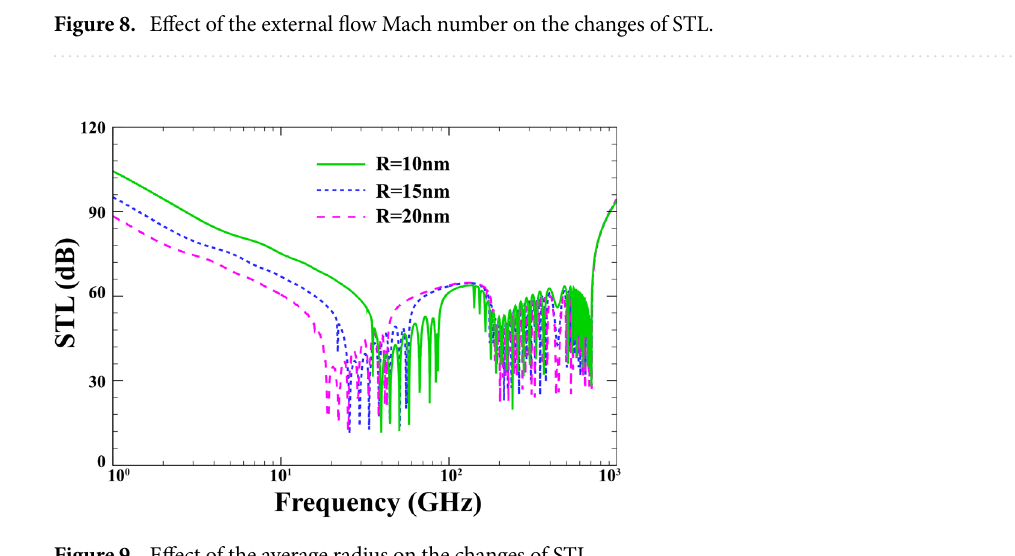
Figure 9. Effect of the average radius on the changes of